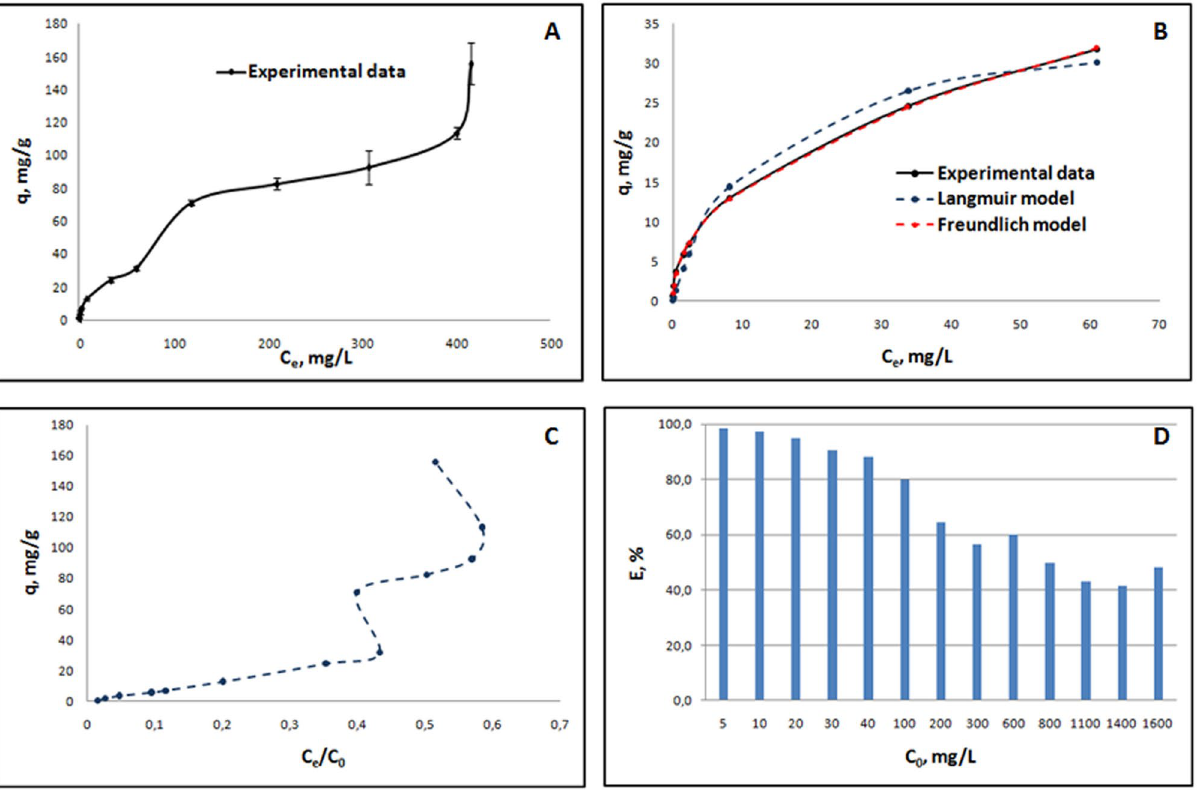
Figure 1. Batch isotherm study of Fe 3+ sorption onto bLTF: ( A ) isotherm of Fe 3+ adsorption onto bLTF for entire concentration range, ( B ) the fit of first sorption step to Langmuir and Freundlich models, ( C ) modified BET isotherm, which presents adsorption as a function of a ratio C e /C 0 , ( D ) bar chart of a sorption efficiency of bLTF depending on the initial concentration of Fe 3+ .